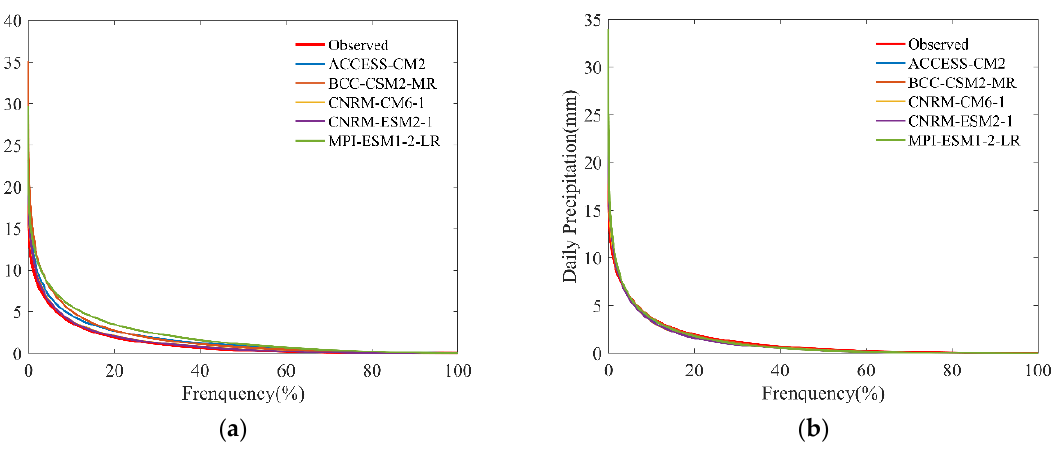
Figure 4. Daily precipitation before and after bias correction from model simulation and observation on daily scale. ( a ) Raw GCMs data and ( b ) corrected GCMs data.